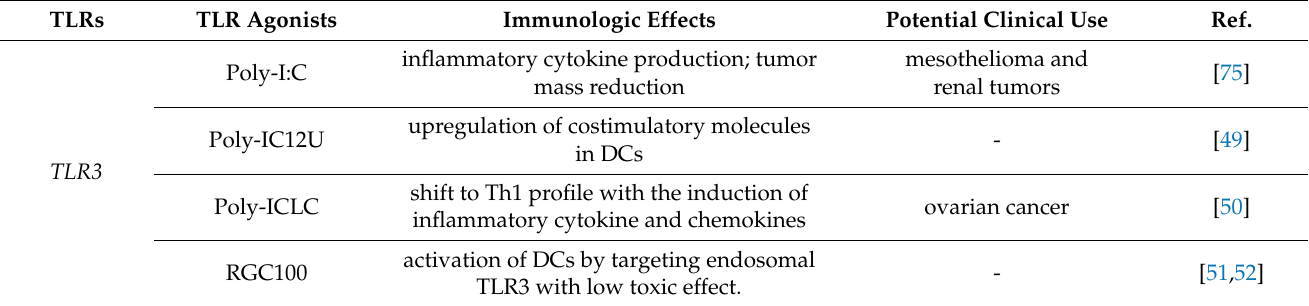
Table 1. Immunologic effects of endosomal TLR agonists used as cancer vaccine adjuvants in